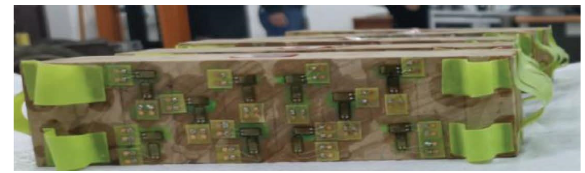
Figure 1: Specimen preparation.